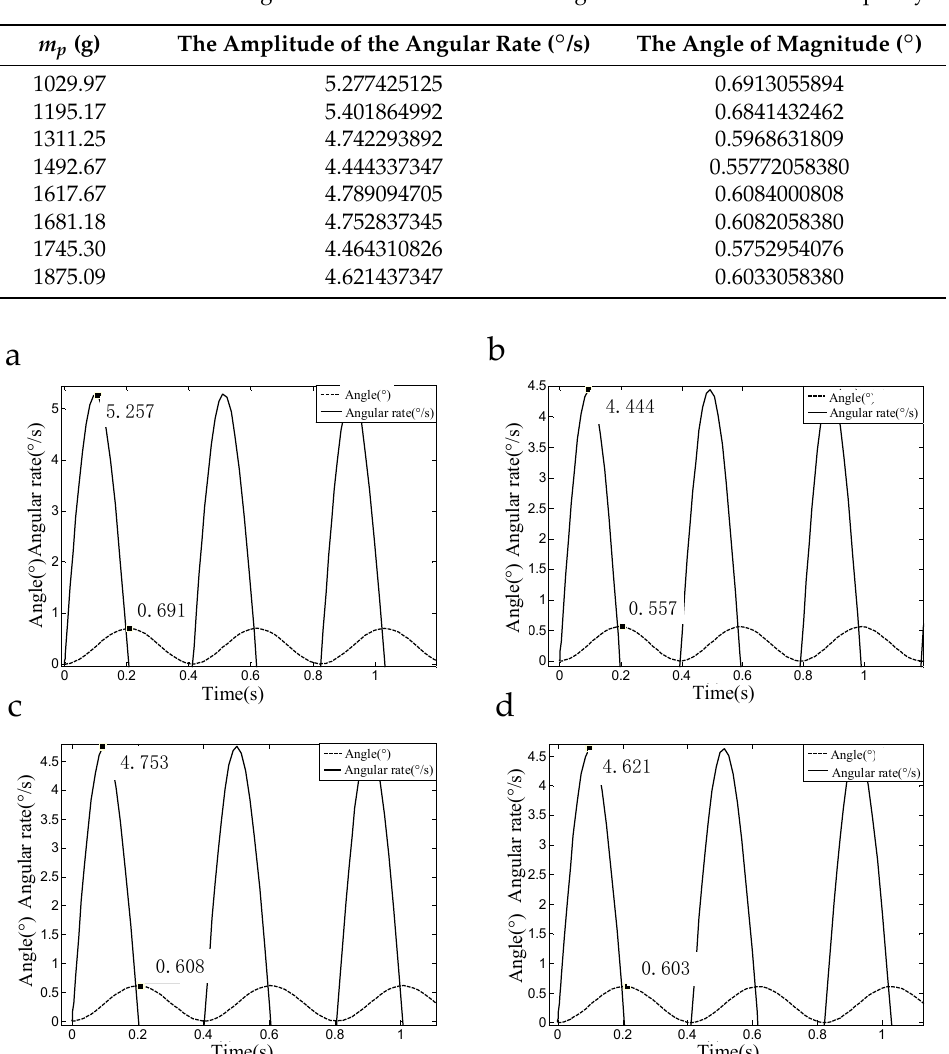
Table 6. The maximum angular rate and the maximum angle of the SSP with different quality.